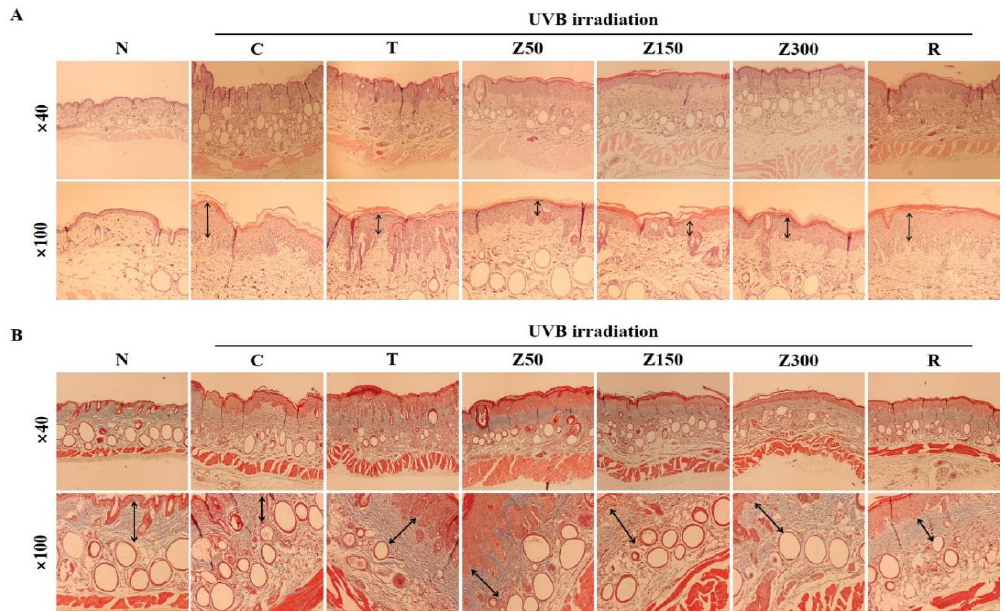
Figure 3. Histological analysis of dorsal surface in tricin- or ETZL-administered SKH-1 hairless mice exposed to UVB irradiation. ( A ) Dorsal skin sections stained with H&E; ( B ) Masson’s trichrome staining. Histological changes were observed at x40 (upper panels) and x100 (lower panels). N, normal control; C, UVB-irradiated control; T, tricin (0.3 mg/kg) oral administration with UVB irradiation; Z50, ETZL (50 mg/kg) oral administration with UVB irradiation; Z150, ETZL (150 mg/kg) oral administration with UVB irradiation; Z300, ETZL (300 mg/kg) oral administration with UVB irradiation; R, UVB irradiation with dermal application of 0.05% retinoic acid.